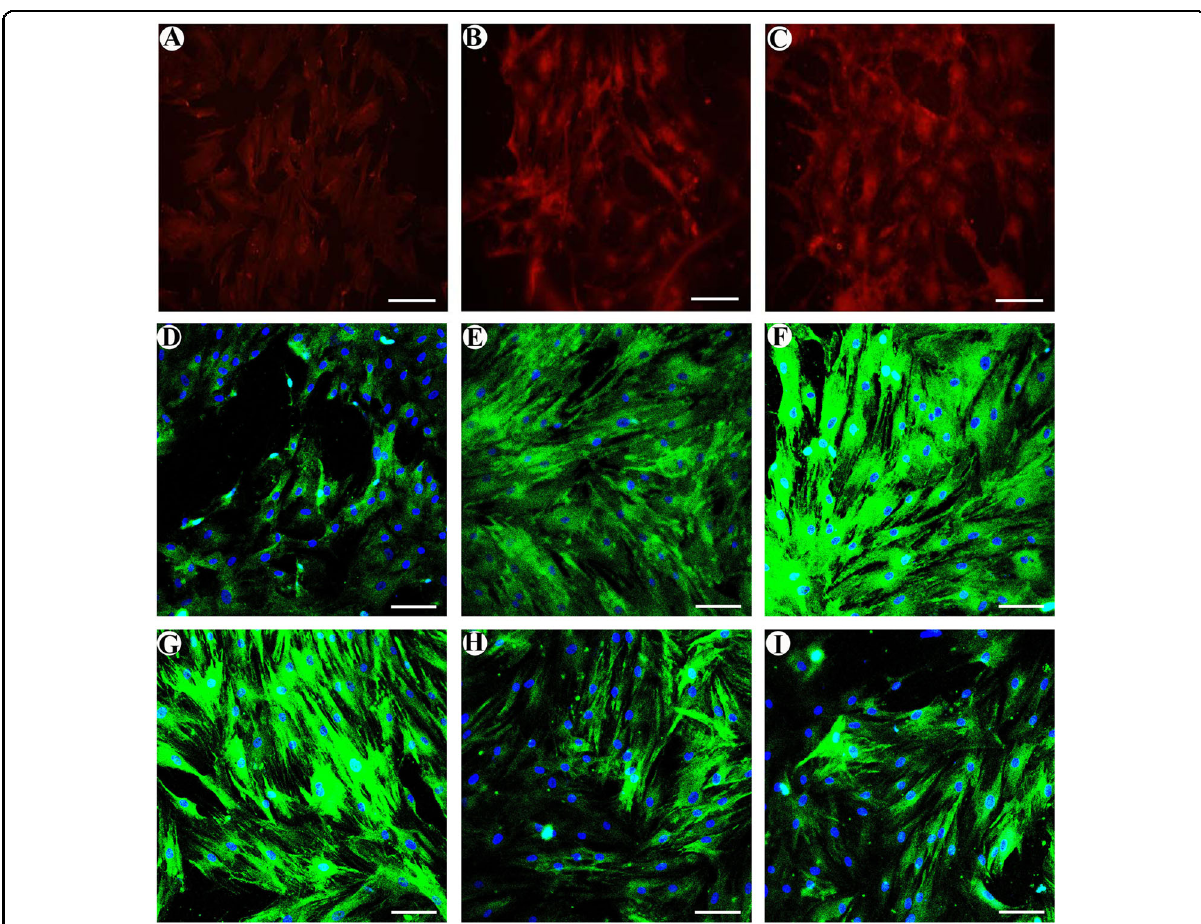
Fig. 2 Immuno fl uorescent staining. MSCs were stained with β -catenin (red), FZD1 (green) and DKK1 (green) antibodies (green), and the cells were co-stained with DAPI to indicate the nuclei (blue). a – c β -catenin showed obviously weak staining in the ONFH group. Following treatment with 5 ′ - Aza-dC, β -catenin staining was obviously increased but was still weaker than that of the control group. d – f FZD1 showed obviously weak staining in the ONFH group. Following treatment with 5 ’ -Aza-dC, FZD1 staining was obviously increased but was also weaker than that of the control group. g – i Dkk1 had strong staining in the ONFH group. Treatment with 5 ′ -Aza-dC obviously decreased Dkk1 staining. The control group had weak Dkk1 staining ( bars 50 μ